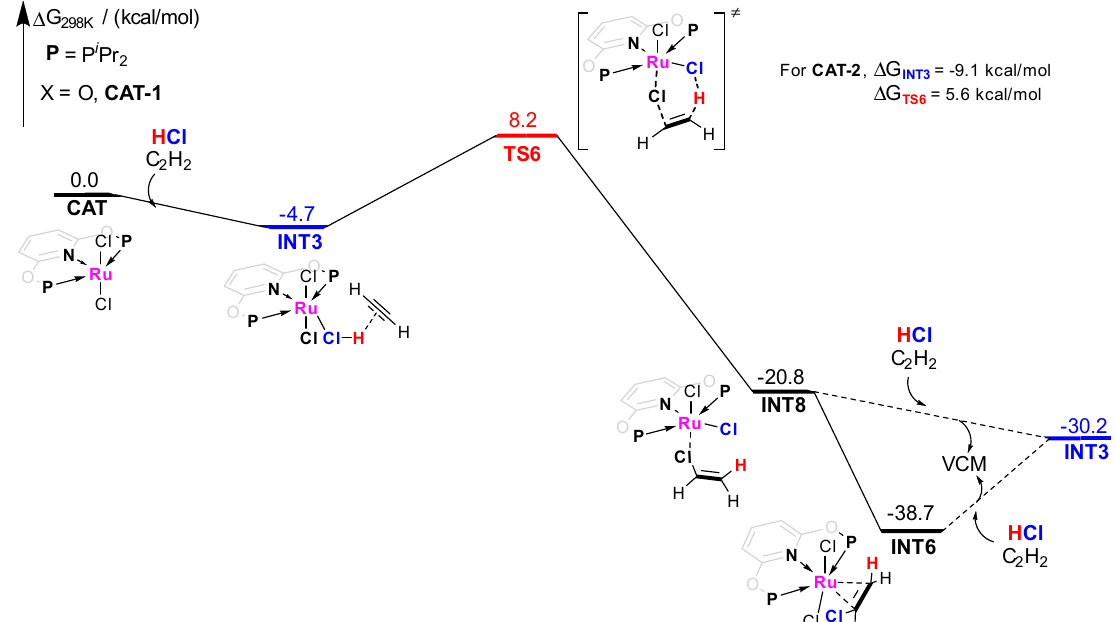
Figure 7. Gibbs free energy profile for molecular complex CAT − 1 catalyzed acetylene hydrochlo- rination mechanism pathway − 3.